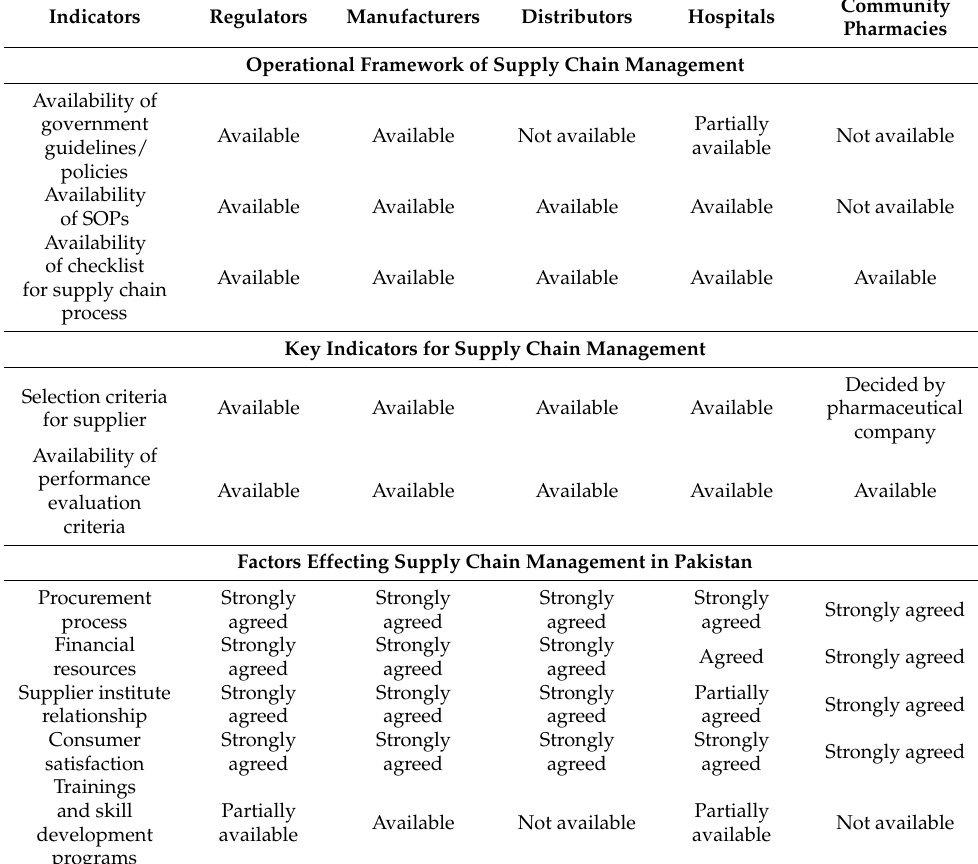
Table 1. Perceptions of stakeholders regarding factors affecting supply chain management of phar- maceuticals products and vaccines in